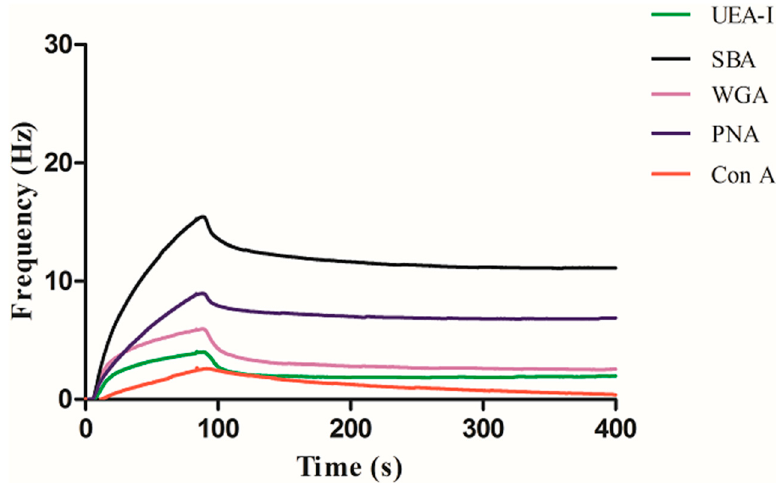
Figure 8. Interaction of galactose with a series of lectins.